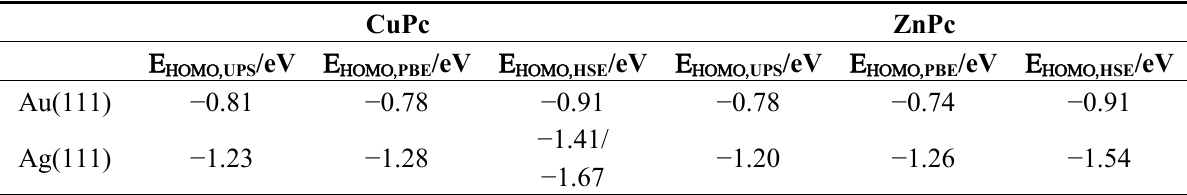
Table 3. Peak positions in the photoelectron spectra and the calculated densities of states associated with the band derived from the molecular HOMO of CuPc and ZnPc for the MePc metal interfaces relative to the Fermi energy. The two HOMO peaks for CuPc on Ag(111) refer to the spin-up and spin-down